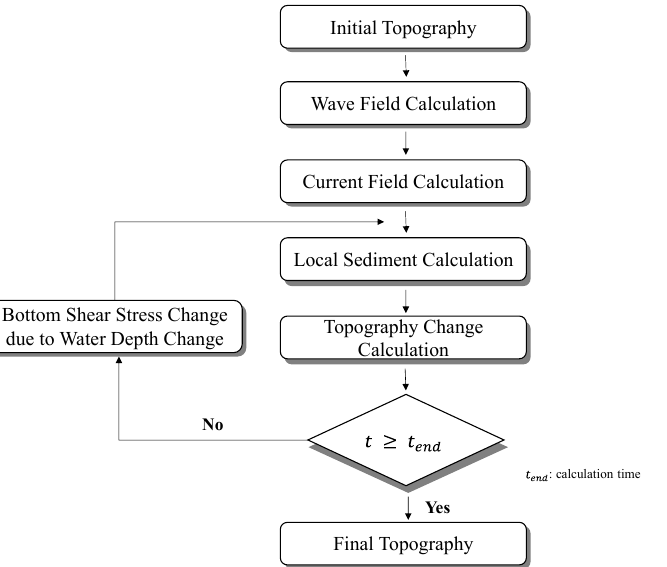
Figure 5. Flow chart of the 3-D Wave-Induced Current Numerical Model process for predicting beach deformation.